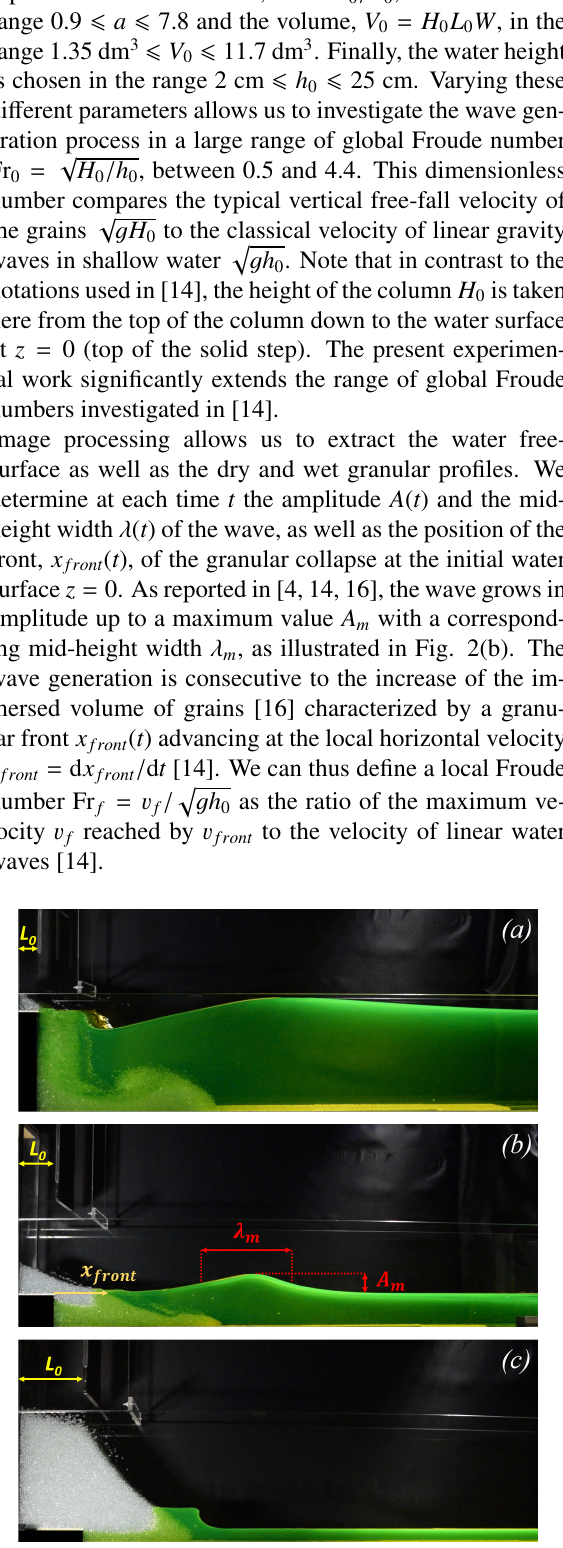
Figure 3. Evolution of (a) the relative wave amplitude A m / h 0 and (b) the relative mid-height width λ m / h 0 with the global Froude number Fr 0 , for all our experiments (solid symbols), and the ones of [18] ( × ); The horizontal dashed line corresponds to the ob- served transition between breaking and non-breaking waves at A m / h 0 (cid:39) 0 . 73.